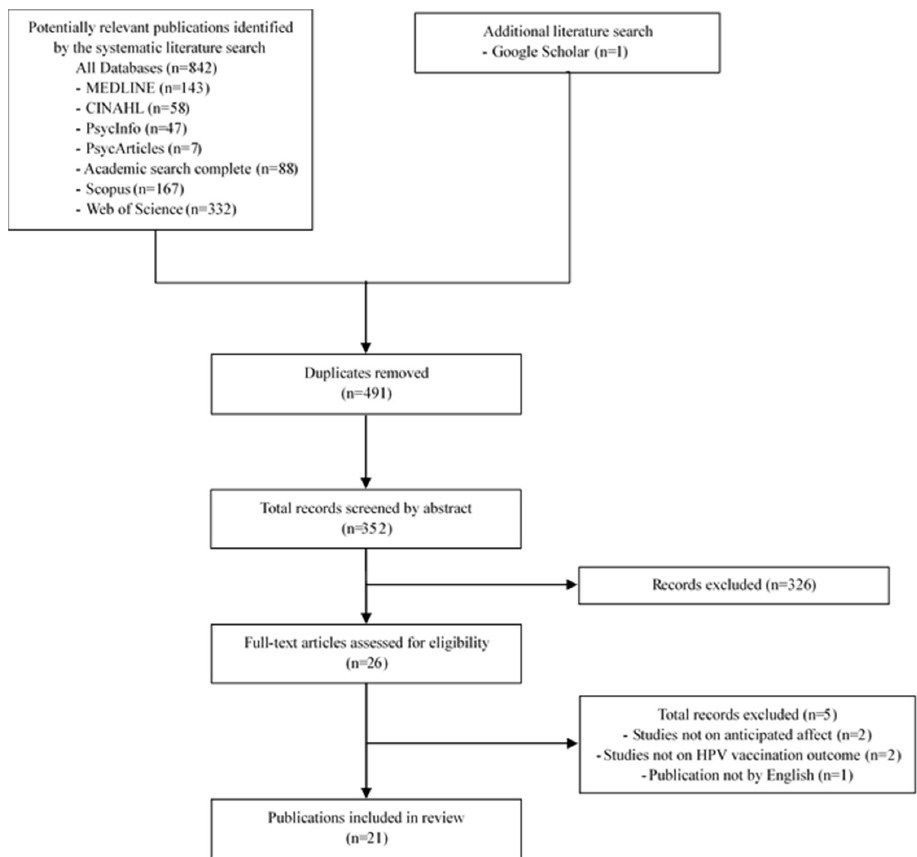
Figure 1. Search process flow chart.